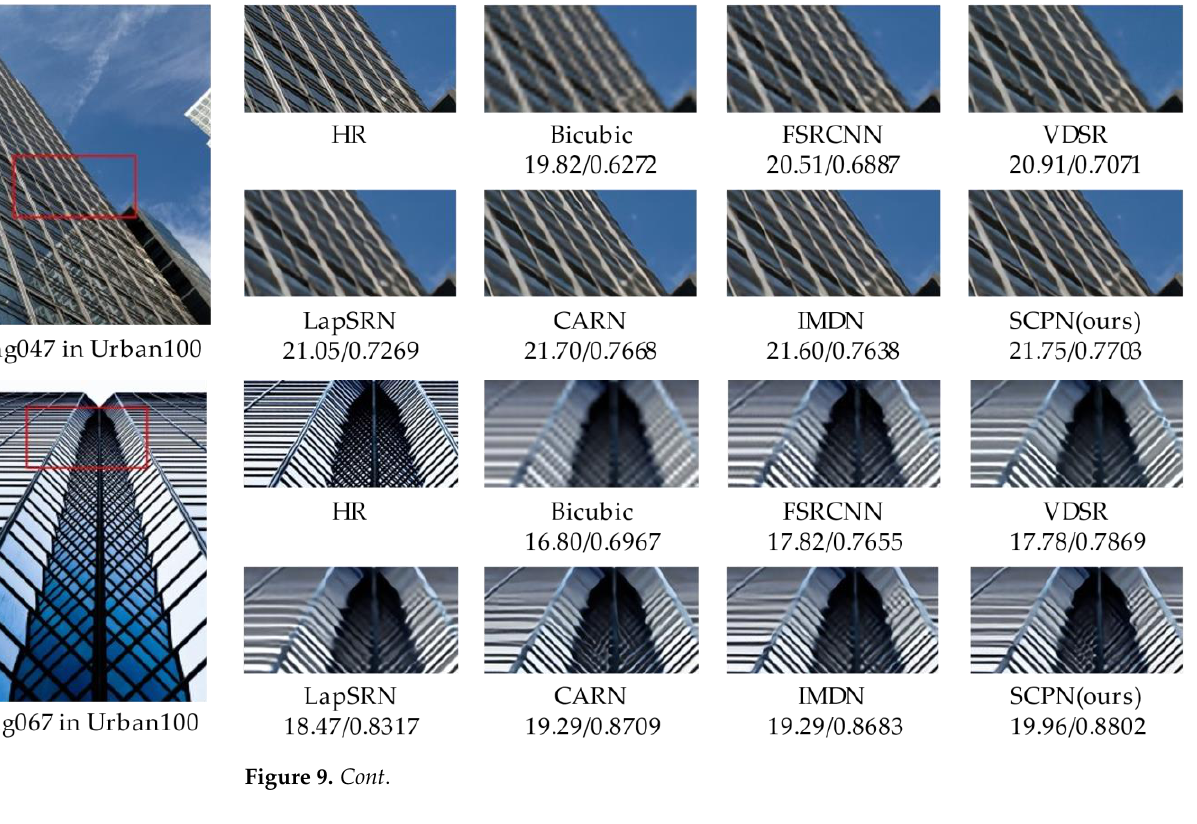
Figure 9. Qualitative results for ×4 SR. The numbers under the name of methods means the PSNR and SSIM values of the corresponding results. 6. Remote Sensing Image Super-Resolution Remote sensing technology is now widely used in agriculture, forestry, military, and other fields. As enhancing the quality of remote sensing images is of great significance,